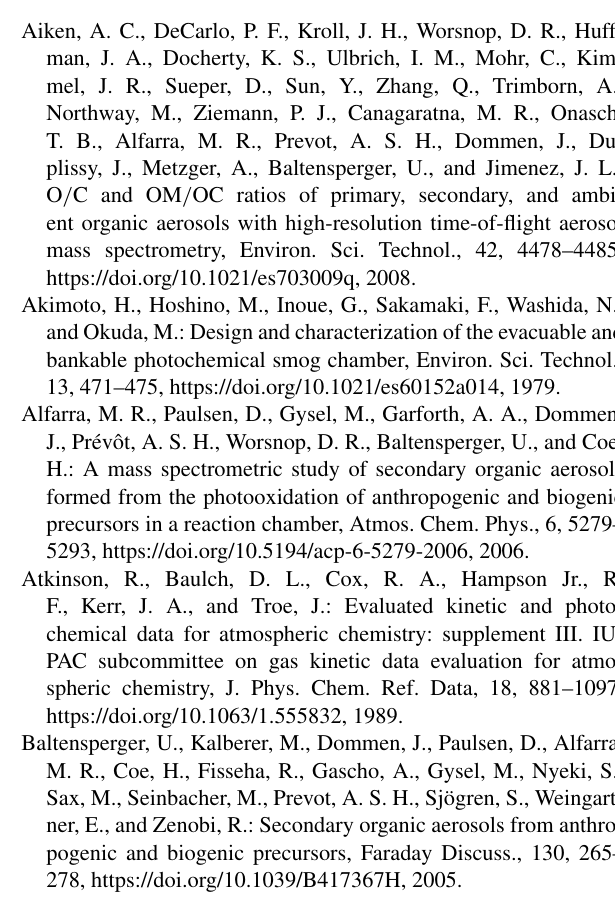
Figshare database (https://doi.org/10.6084/m9.figshare.10026131; Sato et al.,